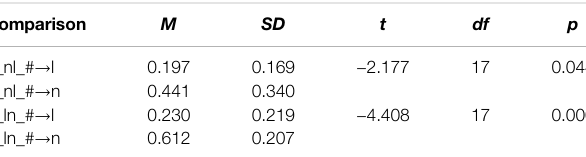
TABLE 8 | t -test results comparing the type of #_nl_# and #_ln_# words.